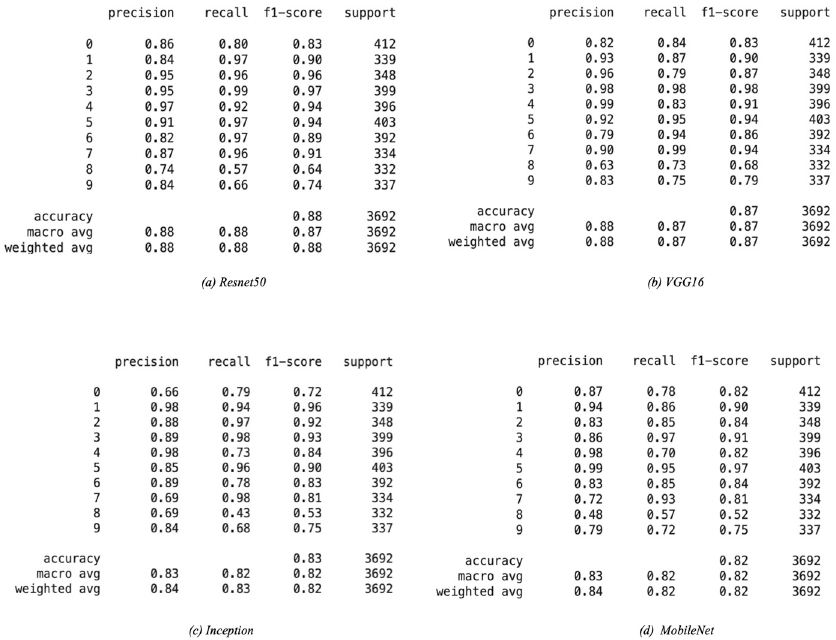
Figure 12. Performance reports for deep learning models on the test set.